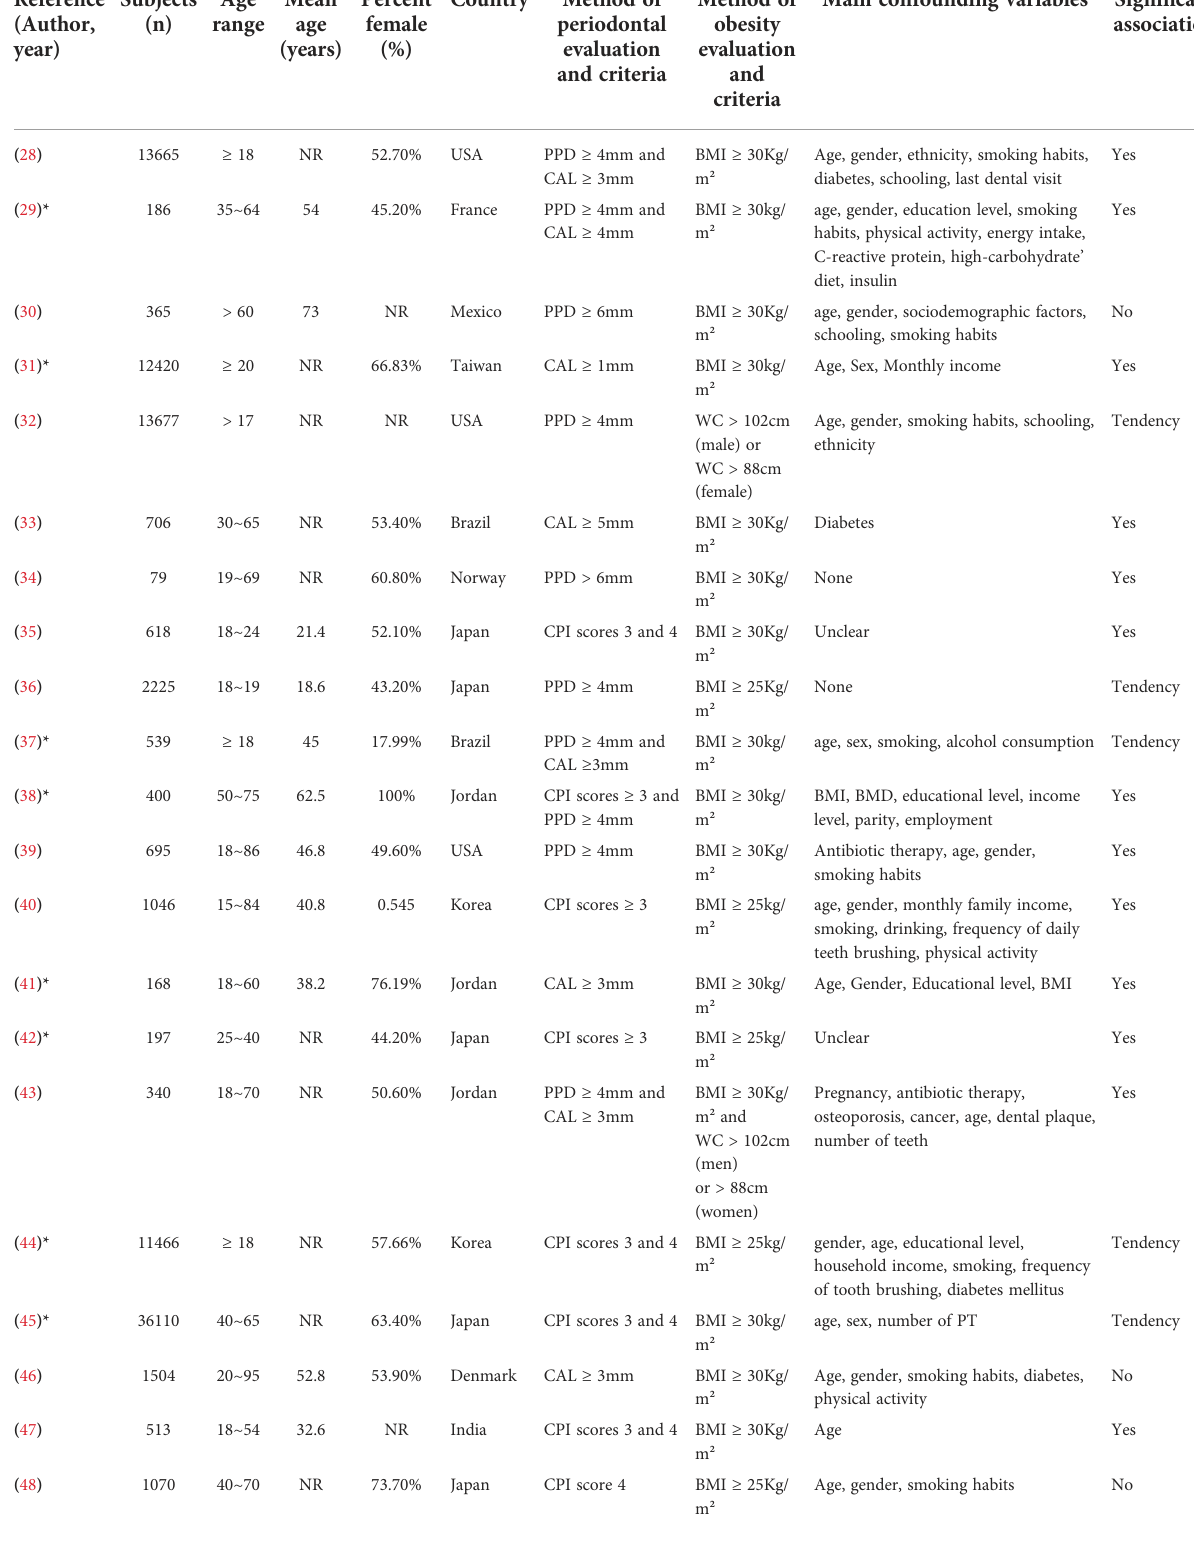
TABLE 1 Characteristics of the included